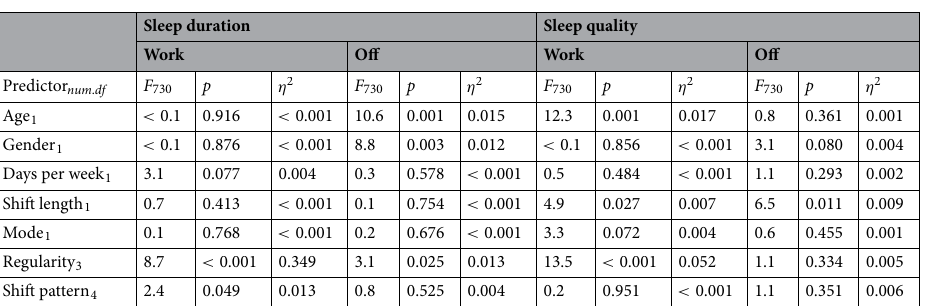
Table 1. ANCOVA for sleep duration and quality on workdays and days off, controlling for age, gender, and number of days per week worked. Post-hocs for gender—days off sleep (F > M), Post-hocs for regularity (regular = 1, somewhat = 2, irregular = 3, very irregular = 4)—workday sleep (1 > 3, 4), day off sleep (4 > 3), workday sleep quality (1, 2, 3 > 4); post-hocs for shift pattern (permanent day or evening = 1, permanent night or other including night = 2, day and evening = 3, day and night = 4, day, evening, and night = 5)—workday sleep (1, 3 > 2); η 2 effect size—small = 0.01, medium = 0.06, large = 0.14 38